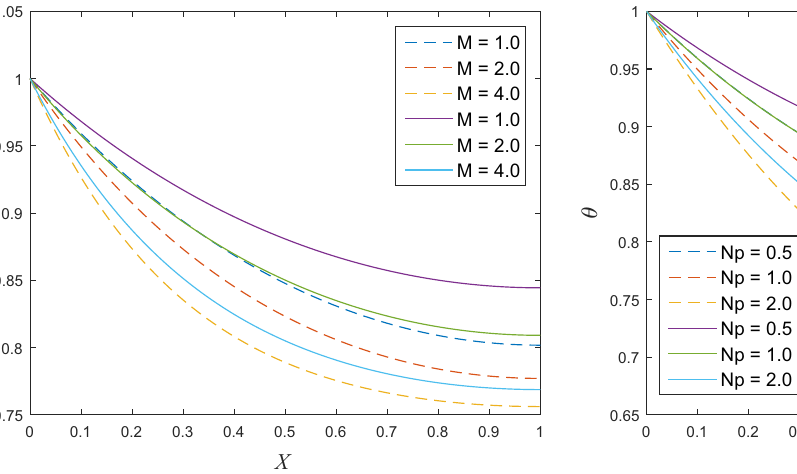
Figure 5: E ff ect of N p (- - linear variation and — non - linear variation ) on the temperature distribution of the fi n.